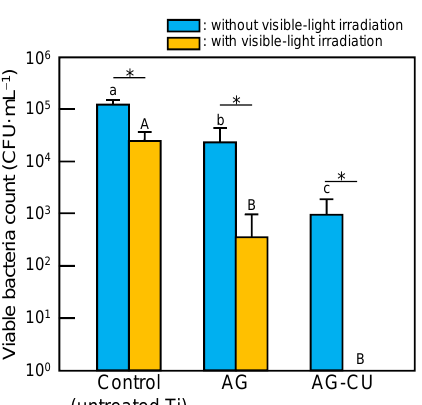
Figure 5. Number of viable bacteria for samples under conditions with and without visible-light irradiation. Bars with different letters (lowercase a – c for no visible-light irradiation group and uppercase A and B for visible-light irradiation group) are significantly different ( p < 0.01). Asterisk (*) represents significant differences ( p < 0.01) between no visible-light irradiation and visible-light irradiation.